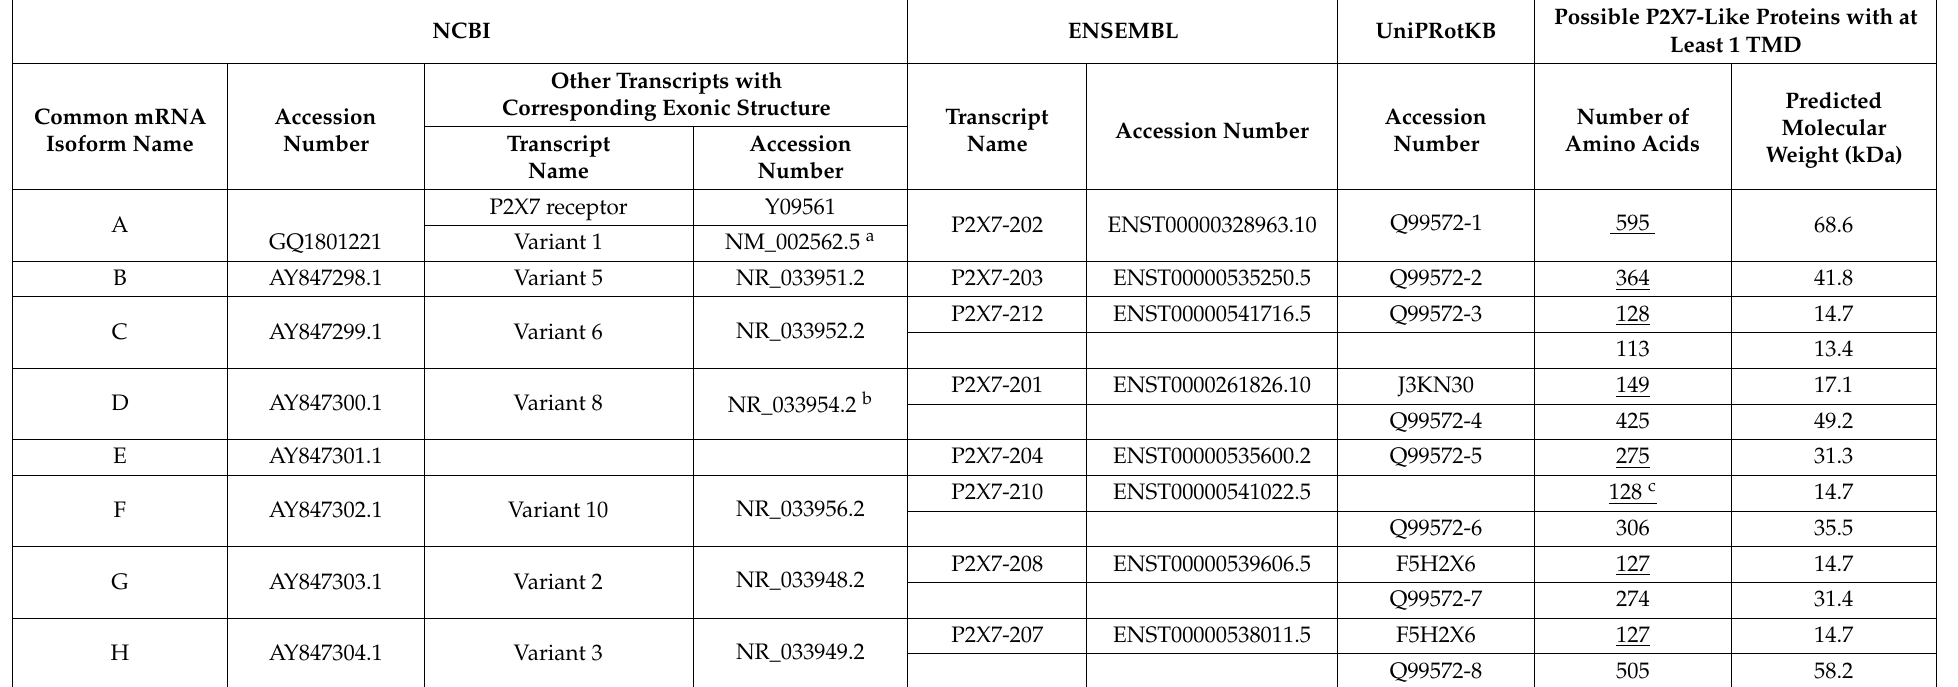
Table 1. Alignment of NCBI and Ensembl transcript isoforms to the commonly used alphabetised naming convention for P2X7R transcripts. Eight protein isoforms are listed on UniProtKB (Q95572-1 to -8) corresponding to the commonly used nomenclature (A–H) as well as four computationally mapped potential isoform sequences. Underlined amino acid numbers indicate sequences translated from the primary start codon. All other numbers refer to P2X7-like proteins that would be translated if alternative start codons were used. Several transcript isoforms are missing in the alphabetised nomenclature: P2X7I has been described as a transcript isoform [13] but has no transcript accession number in NCBI or Ensembl. P2X7I relates to the mutation at the intron 1 donor splice site rs35933842 [80];